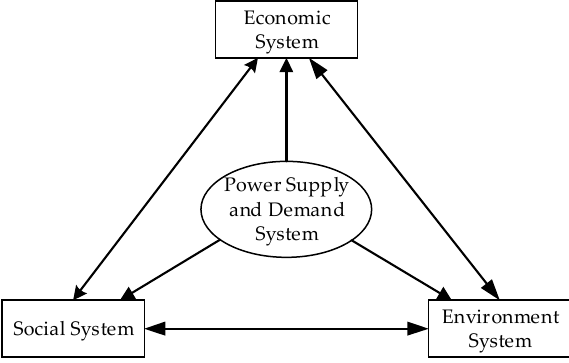
Figure 5. Mechanism of interaction among the systems. Reproduced with permission from [25], Zuo, Y.; Shi, Y.-L.; Zhang, Y.-Z., Sustainability, 2017. Based on the analysis of the interaction among the systems, a causal feedback diagram of system elements was produced, as shown in Figure 6.